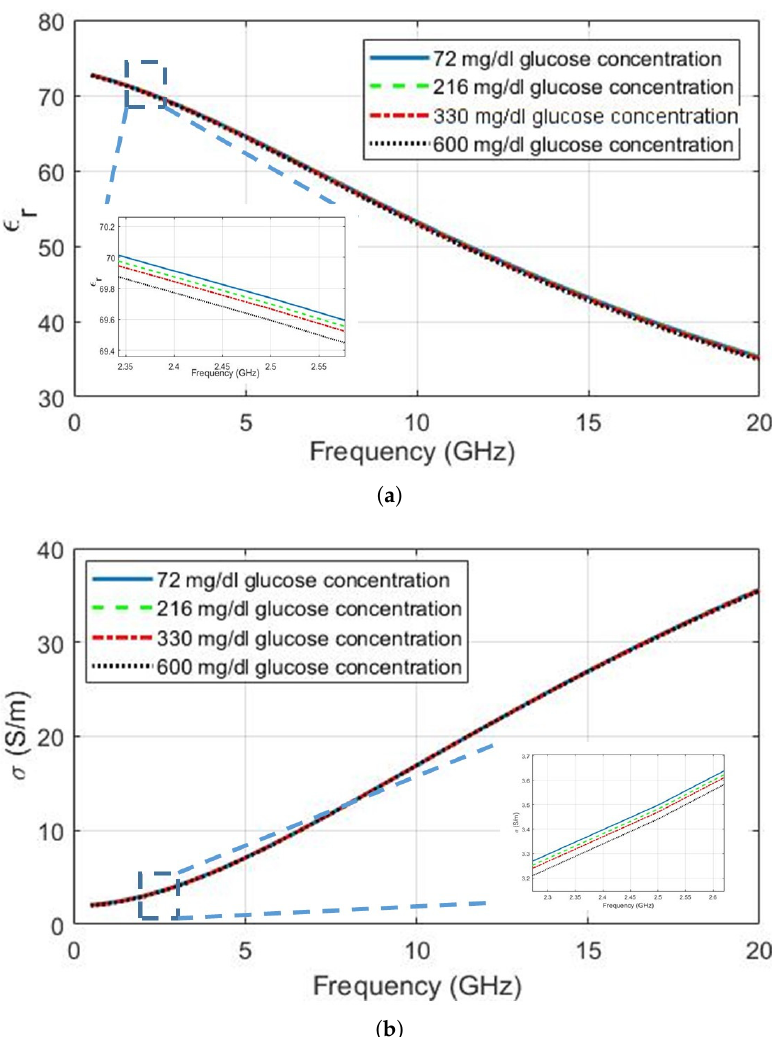
Figure 1. Dielectric properties of blood plasma with glucose variations graphed with Cole–Cole parameters polynomials given in [22]: ( a ) relative permittivity (cid:101) r ; ( b ) conductivity σ